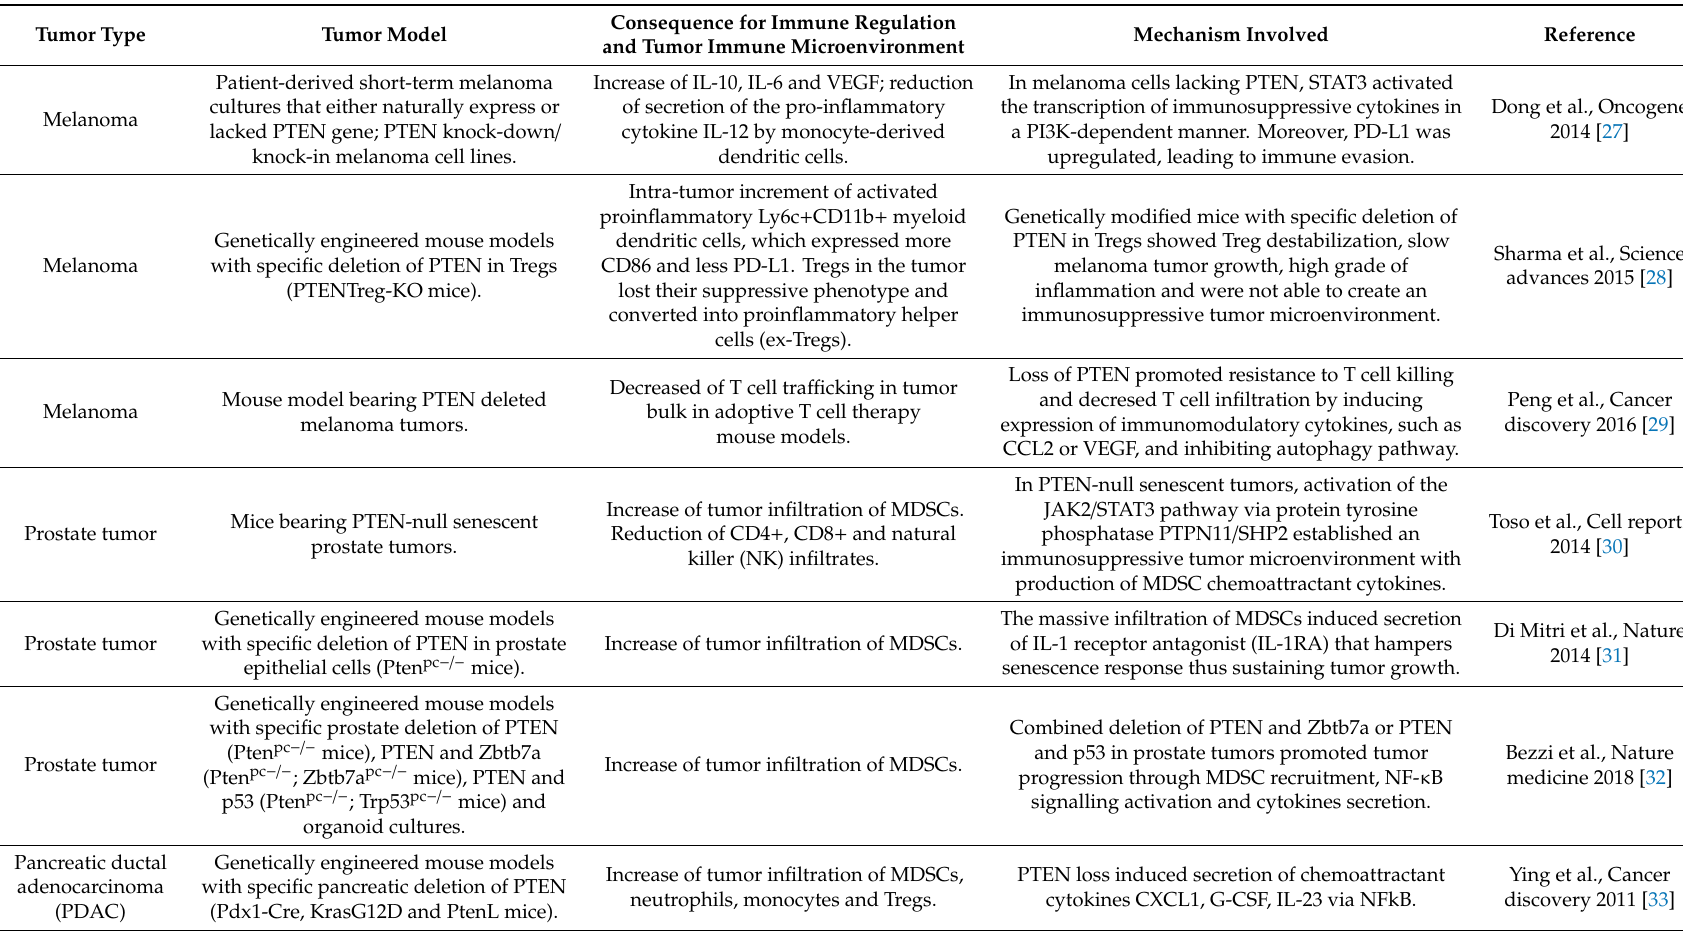
Table 1. Preclinical studies on the role of PTEN pathway in regulation of anti-tumor